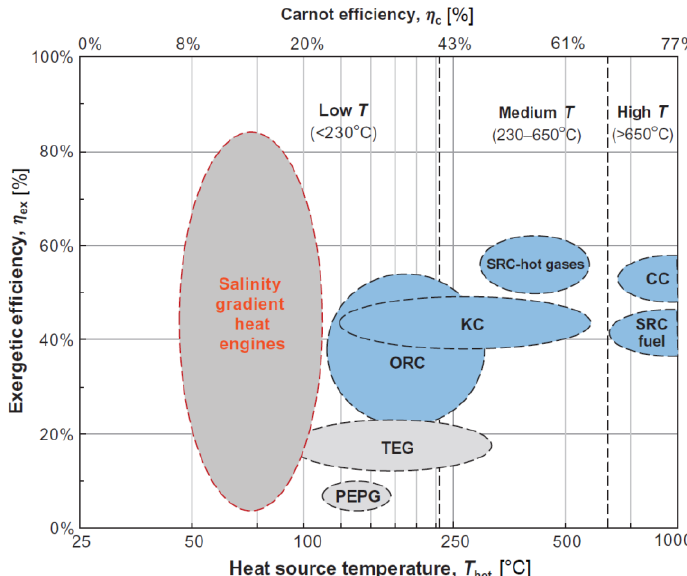
Figure 1. Exergy efficiency range for various thermodynamic cycles as function of the heat source temperature. On the secondary x -axis the Carnot efficiency corresponding to the T hot is shown (considering a constant T cold = 25 ◦ C). The grey circles correspond to technologies still under